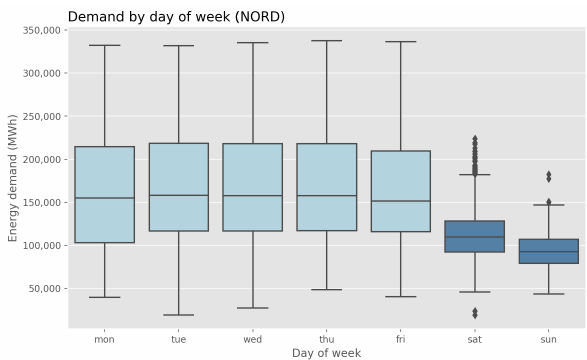
Figure 4. Boxplot of the energy demand by day of the week in NORD.